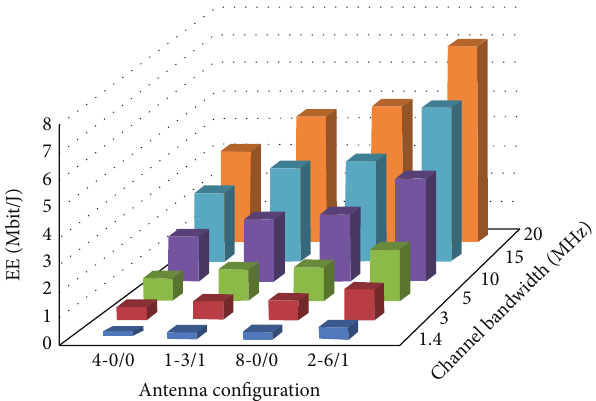
Figure 4: Comparison of EE of DAS and CAS in terms of different antenna configurations and channel bandwidth. High load scenario.